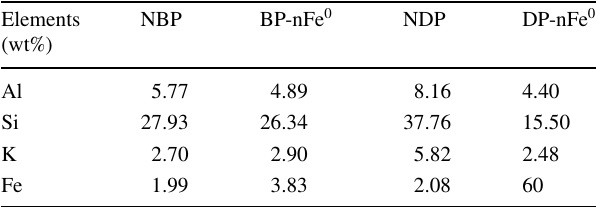
Table 1 Elementary composition of NBP, BP-nFe 0 , NDP and